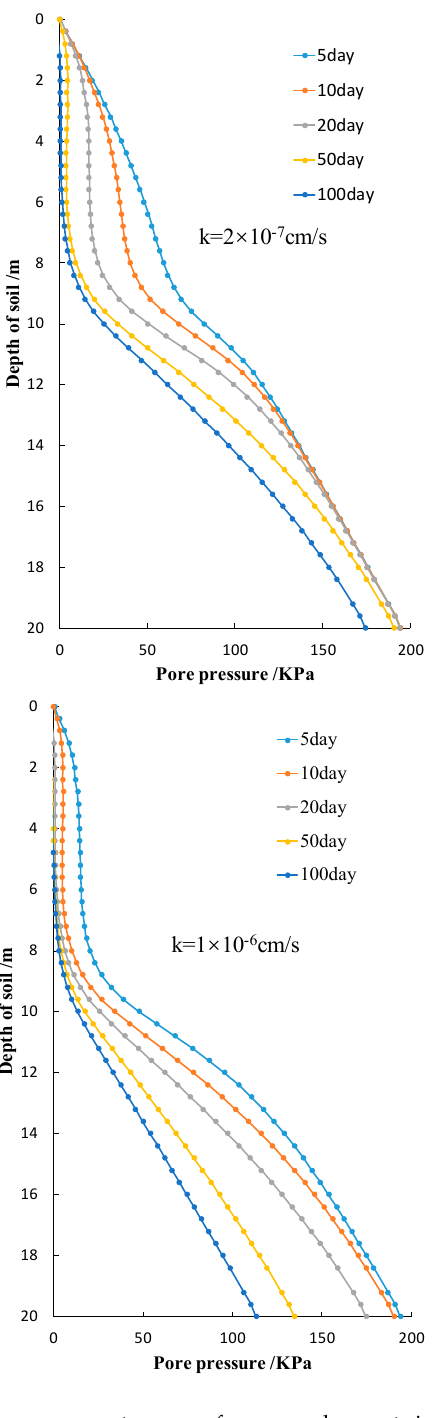
Figure 5. Vertical distribution of soil pore water pressure at corner of square column at siphon hole spacing d = 2 m.